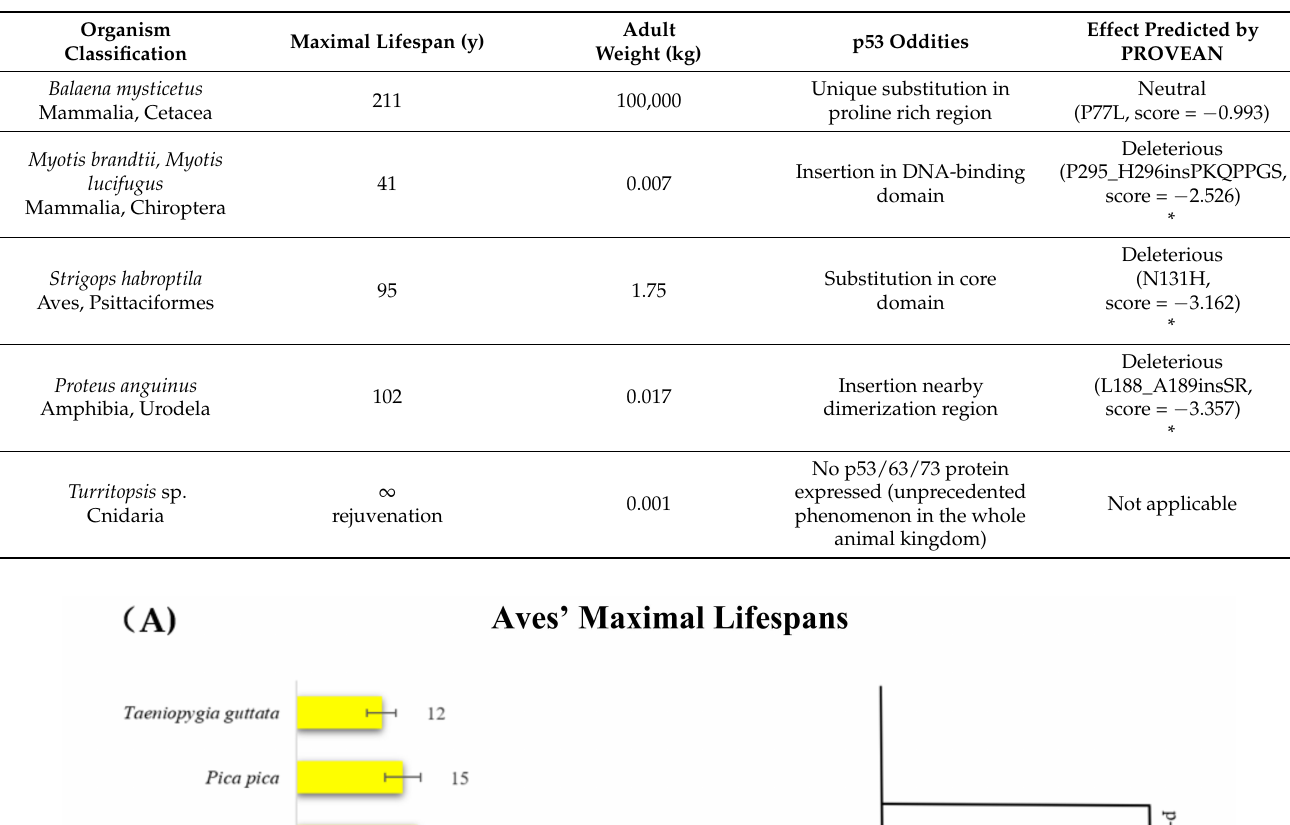
Table 1. Comparison of animals that were characterized by extreme longevity and their atypical p53 features, where the significance of particular changes was predicted. The default PROVEAN threshold of − 2.5 was used, insertions and deletions were submitted relative to the human canonical protein sequence (NP_001119584.1). “*” indicates significant PROVEAN values (< − 2.5).